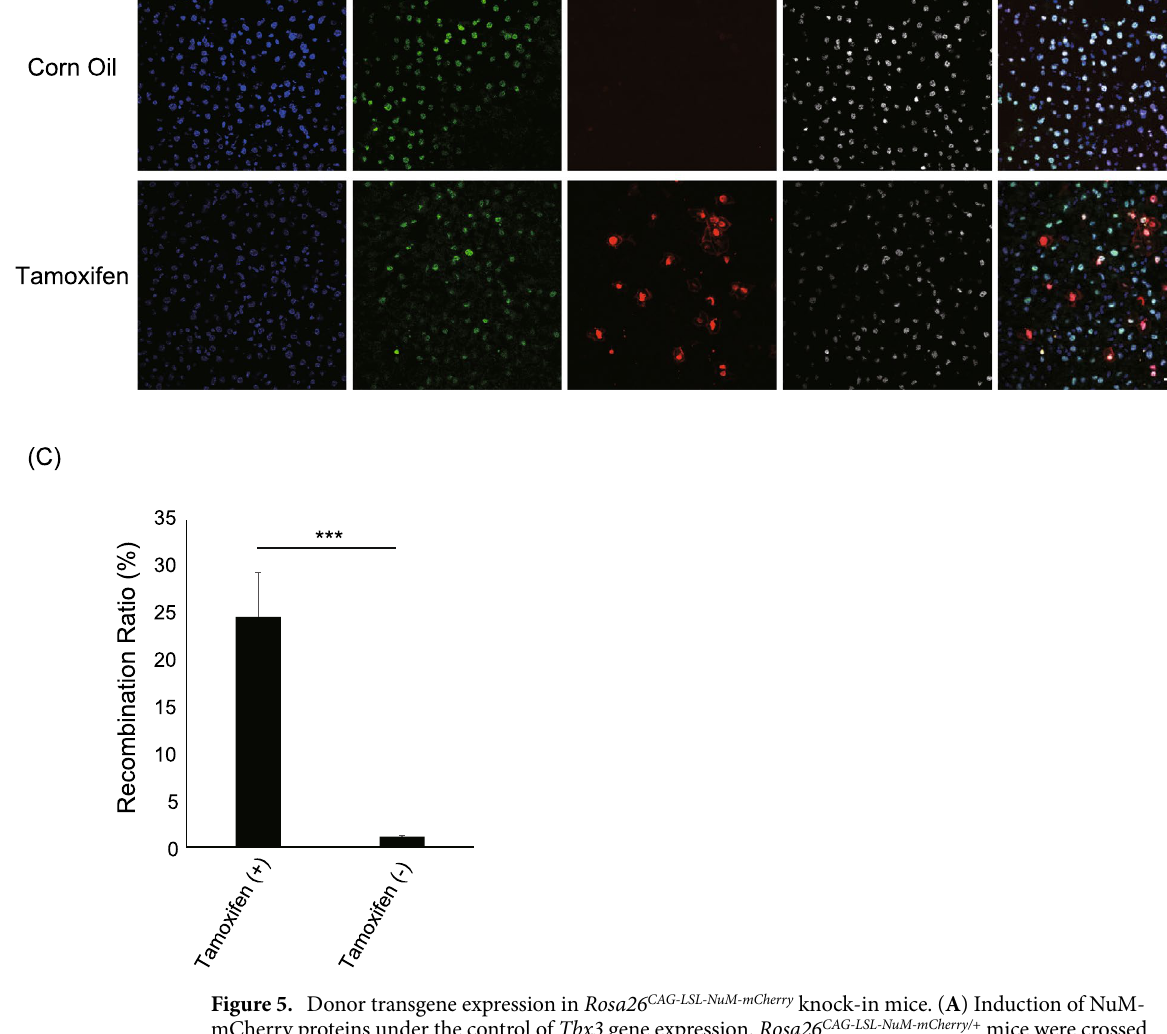
Figure 5. Donor transgene expression in Rosa26 CAG-LSL-NuM-mCherry knock-in mice. ( A ) Induction of NuM- mCherry proteins under the control of Tbx3 gene expression. Rosa26 CAG-LSL-NuM-mCherry/ + mice were crossed with Tbx3 CreERT2/ + mice to generate Rosa26 CAG-LSL-NuM-mCherry ; Tbx3 CreERT2 hemizygous mice. Intraperitoneal administration of tamoxifen into mice induced NuM-mCherry expression under the control of CreERT2 in the Tbx3 + cells. ( B ) Representative immunofluorescence images of liver tissue in the Rosa26 CAG-LSL-NuM-mCherry ; Tbx 3 CreERT2 mice administered control corn oil or tamoxifen. Tbx3 (green), NuM-mCherry (red), HNF4α (white), and DAPI (blue). Scale bar, 20 µm. ( C ) Recombination ratio in the control and tamoxifen-administered Rosa2 6 CAG-LSL-NuM-mCherry ; Tbx3 CreERT2 mouse livers. The recombination ratio was calculated by the percentage of NuM- mCherry + cells among Tbx3 + HNF4α + cells (n > 300 cells from three individual slides). Mean ± s.d. from three individual slides. *** P < 0.01, by two-tailed Student’s t